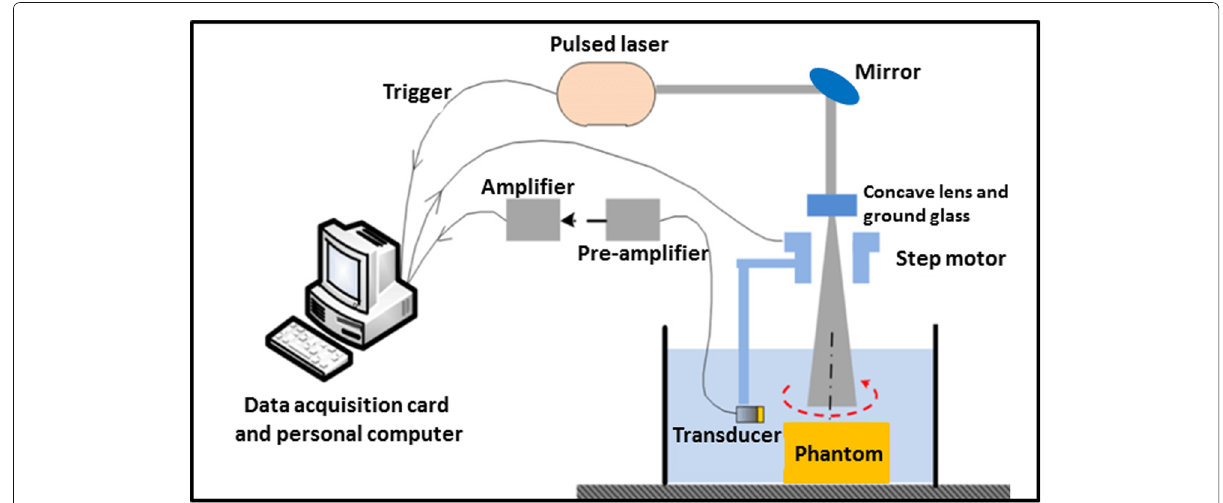
Fig. 3 Experimental setup used for the photoacoustic tomography acquisitions